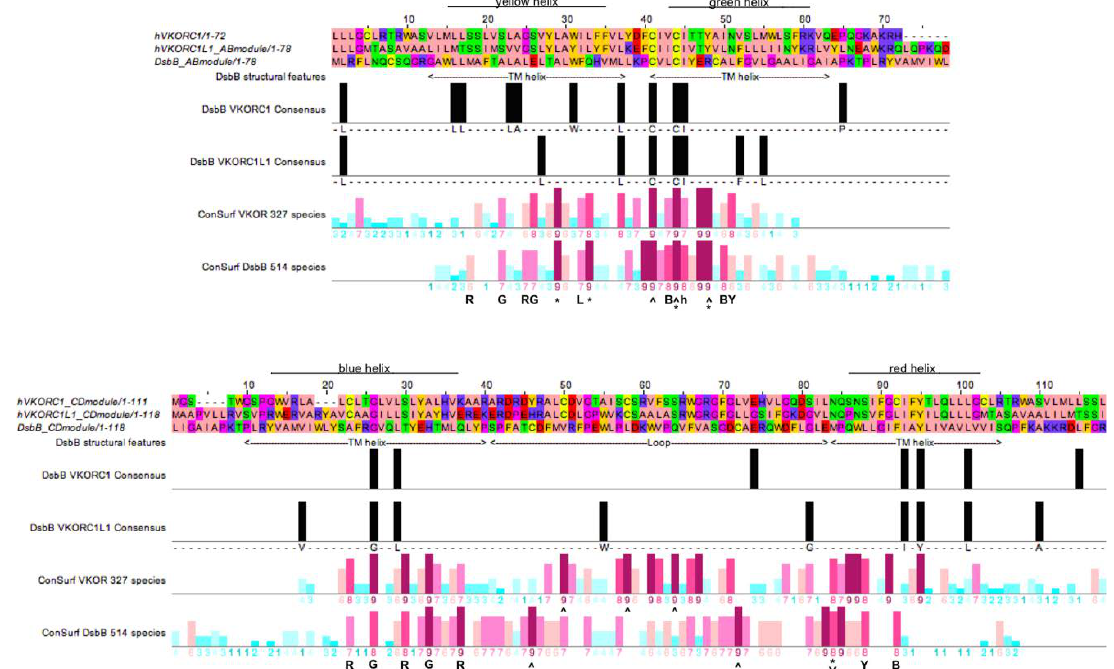
Figure 5. Alignment of helix pair-loop module sequences of VKORC1, VKORC1L1 and DsbB showing pairwise identity, Consurf conservational scoring and known DsbB secondary structure elements and interhelical packing residues (Note 1 [67]). ClustalW2 alignments for AB (top) and CD (bottom) modules. Positions of transmembrane helices for DsbB are indicated below alignment, helix color indicated above alignment. Vertical black bars, sequence identity between DsbB and VKOR proteins; bottom two lines, Consurf conservation scores for VKOR multiple sequence alignment (second from bottom line) and DsbB multiple sequence alignment (bottom line). Vertical colored bars, positional conservation as described in Figure 4—Letters and symbols below conservation score lines: R = interhelical contact to red helix, G = interhelical contact to green helix, B = interhelical contact to blue helix, Y = interhelical contact to yellow helix, * = residue making contact with quinone cofactor, L = residue mediating hydrophobic packing against a C-terminal segment of the large loop, ^ = residues completely conserved in all species, h = residue making hydrophobic contact with the small amphipathic helix of the large loop.